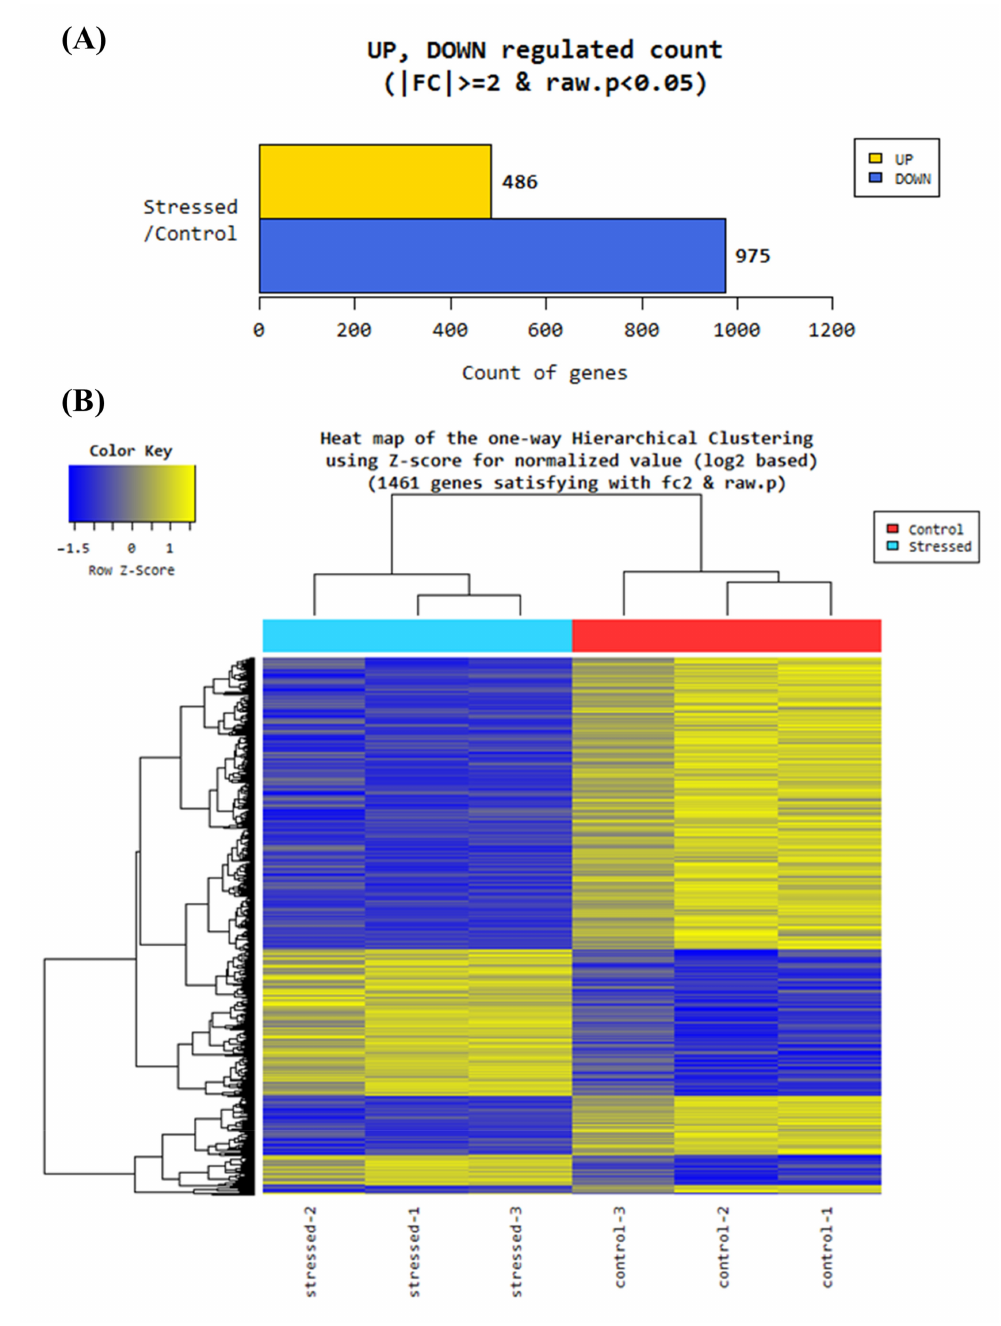
Figure 3. Hierarchal clustering of differentially expressed genes in maize roots induced by 24 h hypoxia. ( A ) In RNA-Seq analysis of maize roots under 24 h of hypoxia, 29,703 normalized genes were analyzed, of which 486 were differentially up- and 975 were differentially downregulated based on 2-fold change and p < 0.05. ( B ) The heat map of the hierarchical clustering of the differentially expressed genes revealed clusters of up- and downregulated